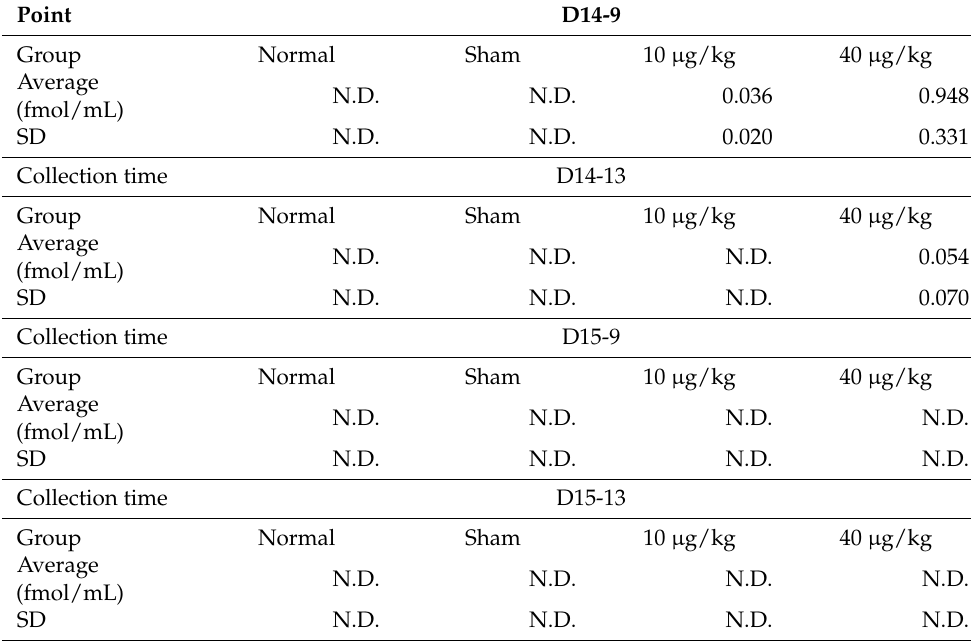
Table 1. Blood concentration of DEX in experimental